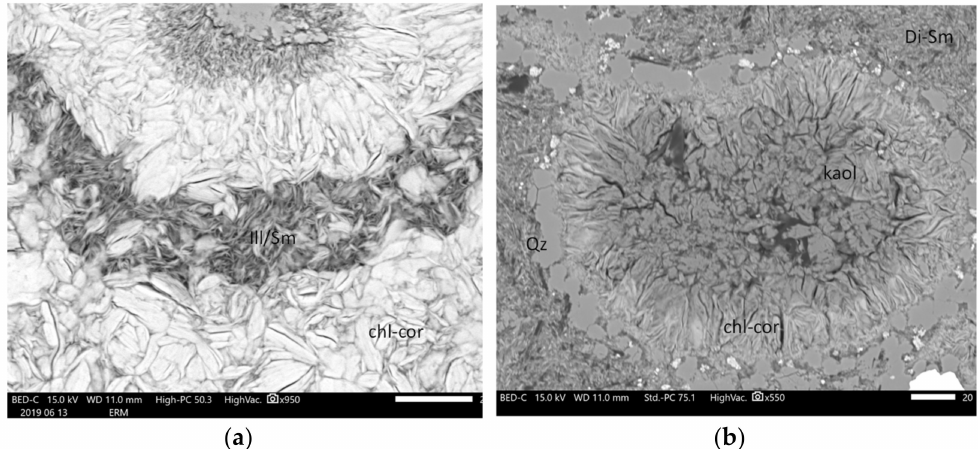
Figure 12. SEM petrographic observations in back-scattered electron mode. ( a ) Ill/Sm R1 crosscutting earlier chlorite and corrensite ( ± Chl/Cor) in basaltic lava at 344.5 m; and ( b ) kaolinite (kaol) replacing earlier chlorite and corrensite in vugs (chl-cor). Di-Sm: dioctahedral smectite in the groundmass in basaltic lava at 305.0